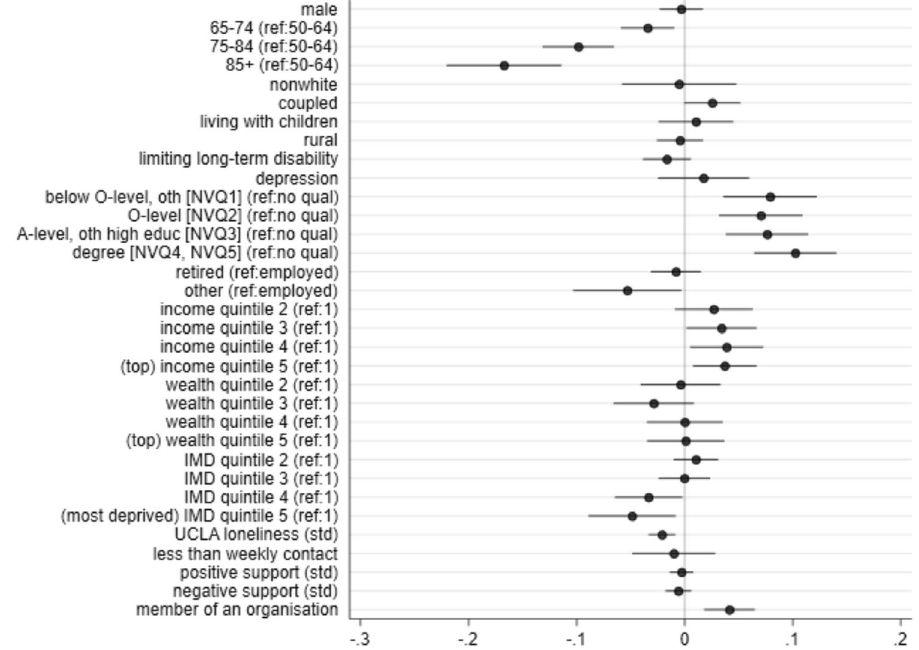
Figure 3. Associations between Internet use and pre-pandemic demographic, economic, and social characteristics. Estimates are from regressing daily Internet use in June/July 2020 (outcome mean 0.757) on the pre-pandemic characteristics ( n = 5475). This regression additionally controls for pre-pandemic daily Internet use and Government Office Regions. Not shown in this figure is the estimate for past daily Internet use (coefficient estimate = 0.610, P < 0.01). The full regression output is in Supplementary Table S4. Std = standardised